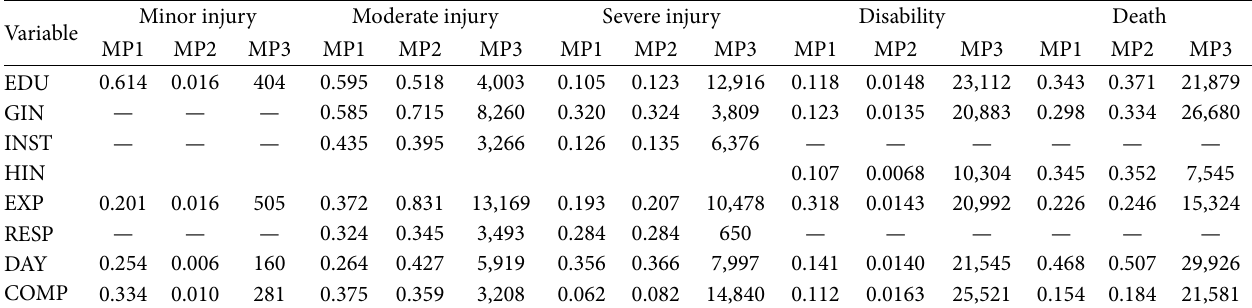
Table 7: Marginal probability results from Double-Hurdle